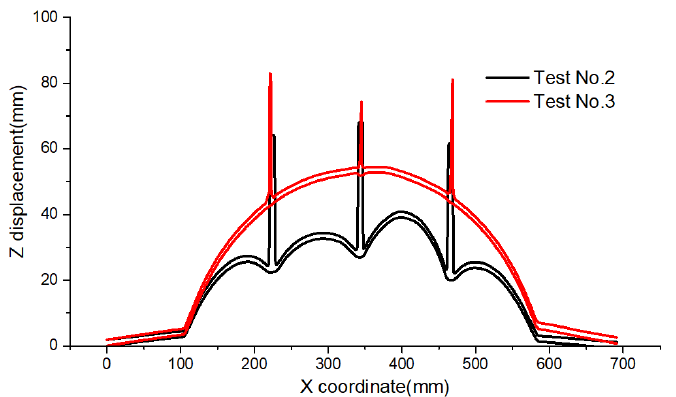
Figure 21. Central H-H section profile of Tests No. 2 and 3.